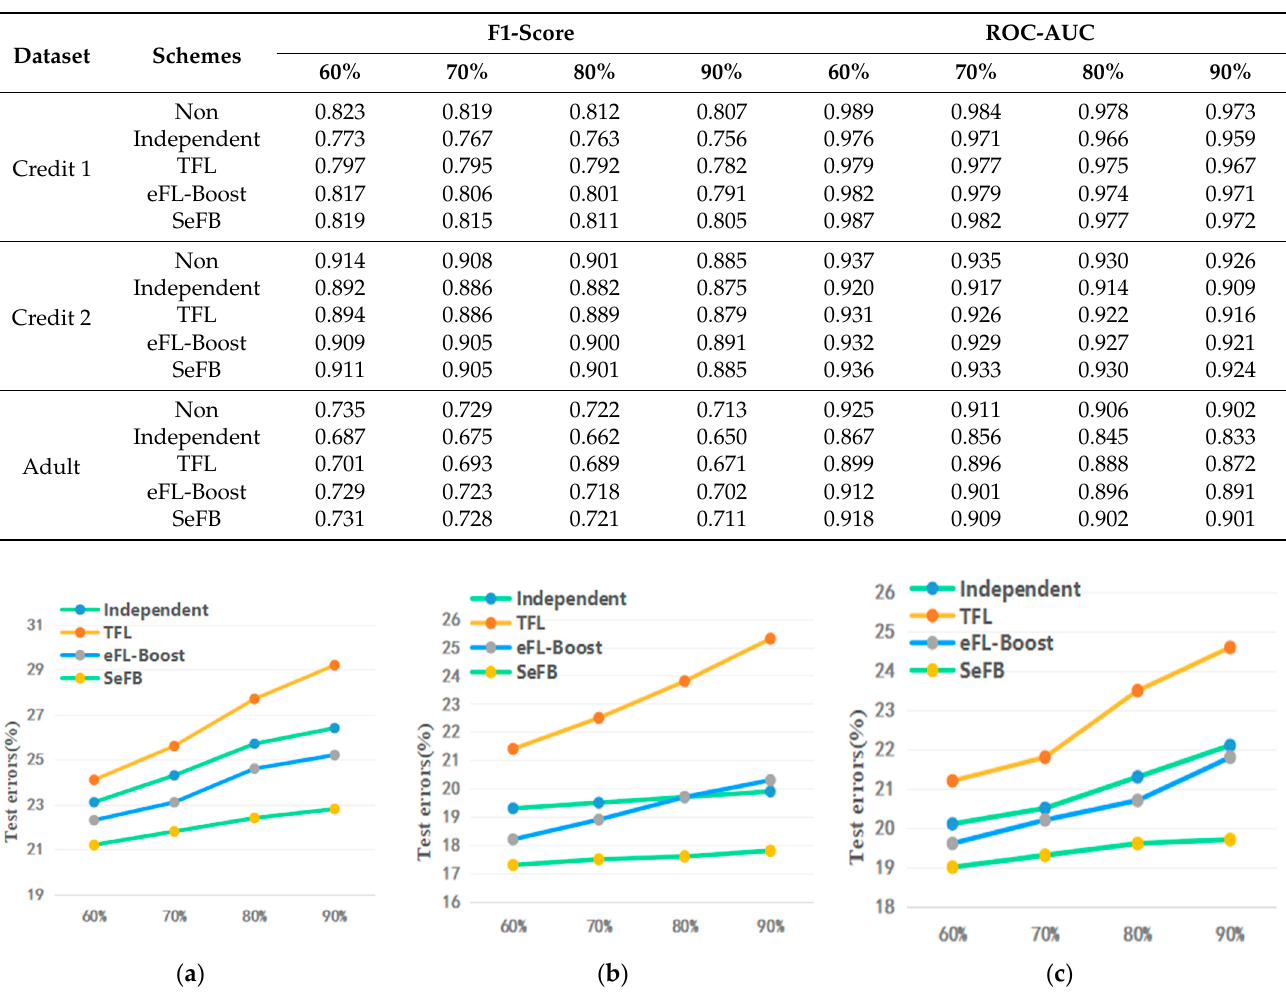
Table 8. Performance impact of data volume size.